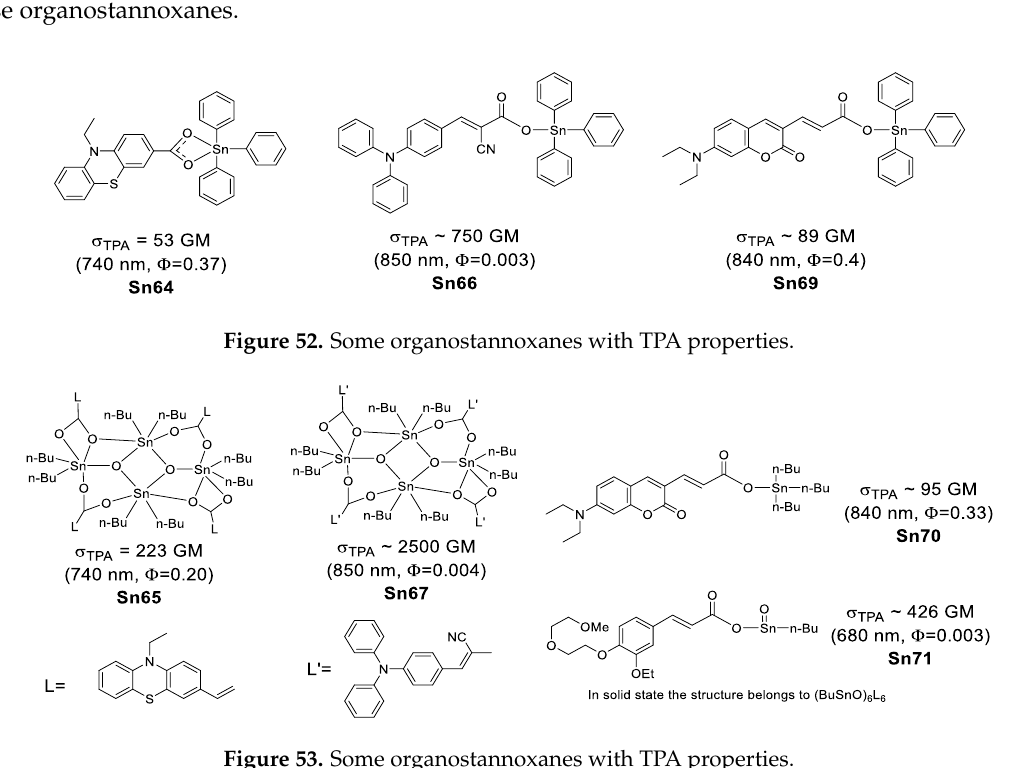
Table 8. Optical properties of the organostannoxanes.